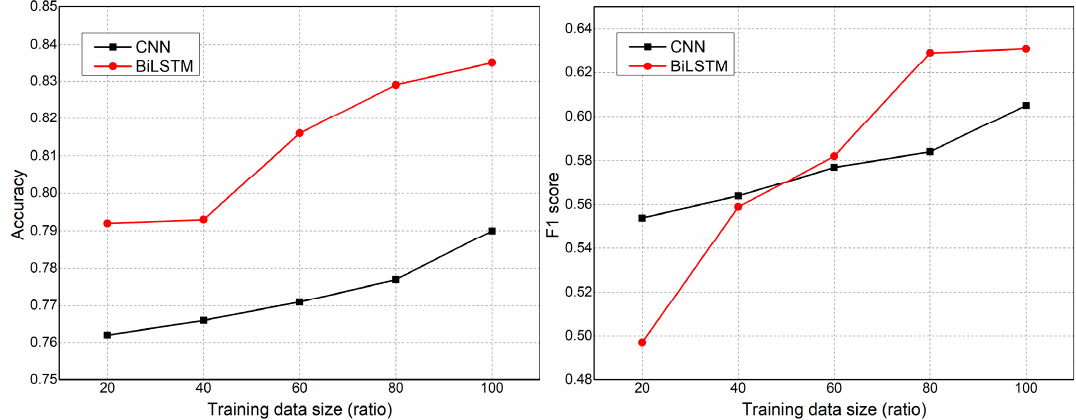
Figure 4. Learning curve.